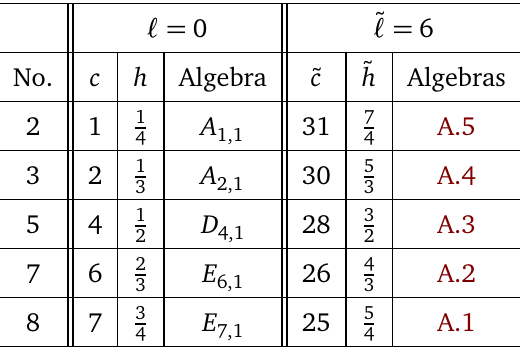
Table 3: (cid:96) = 6 coset duals for simply laced algebras